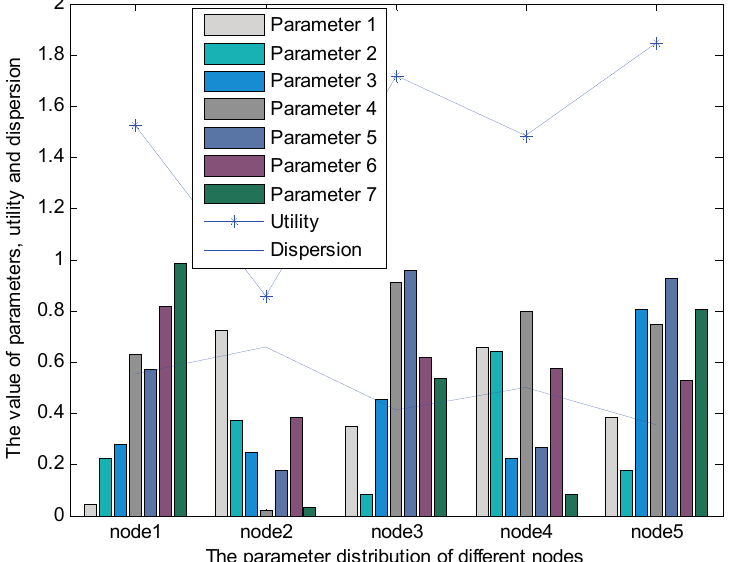
Figure 7. The result of the BCFL under multiple